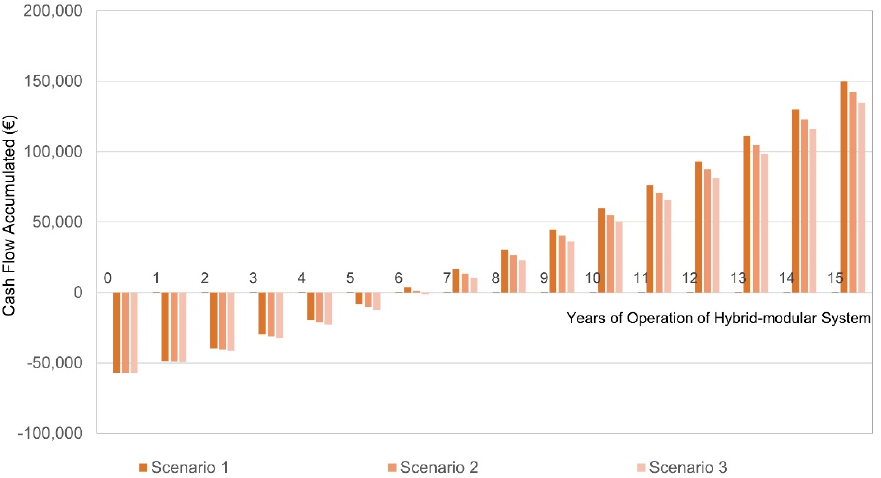
Figure 11. Economic performance approach of the hybrid modular system (in terms of cash flow and cash flow accumulated over a time span of 15 years.